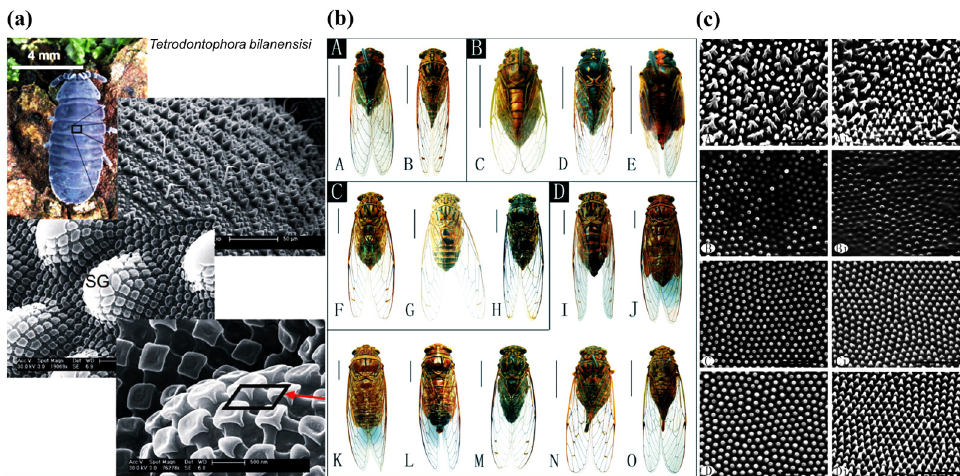
Figure 7. Organisms with superamphiphobic wetting properties: ( a ) SEM images of Springtail [89], ( b ) Cicada [91], ( c ) Surface microstructure of different cicadas [91].